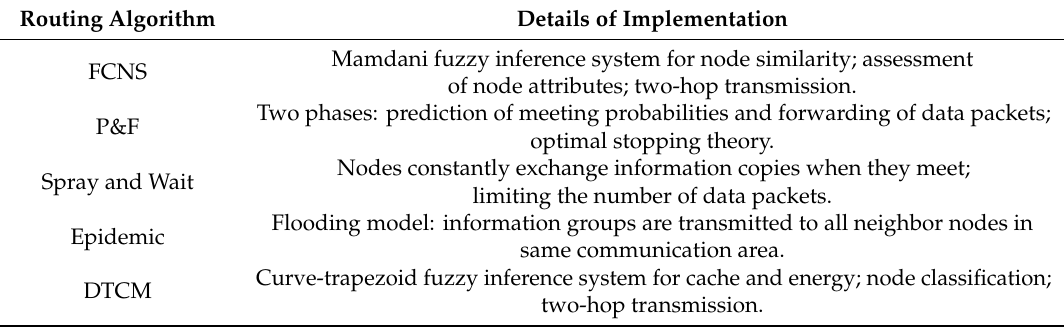
Table 2. The details of implementation of the compared five